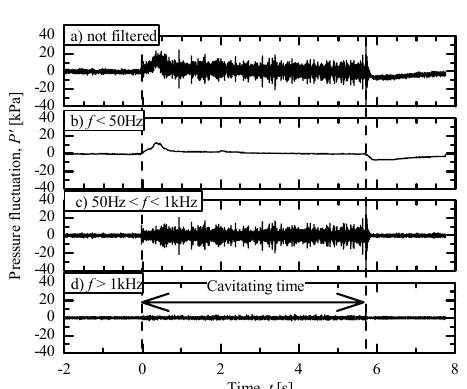
Fig. 8 Time evolution of the pressure fluctuation upstream of the nozzle in the intermediate cavitation type: a) not filtered, b) low pass filtered, c) band pass filtered, and d) high pass filtered